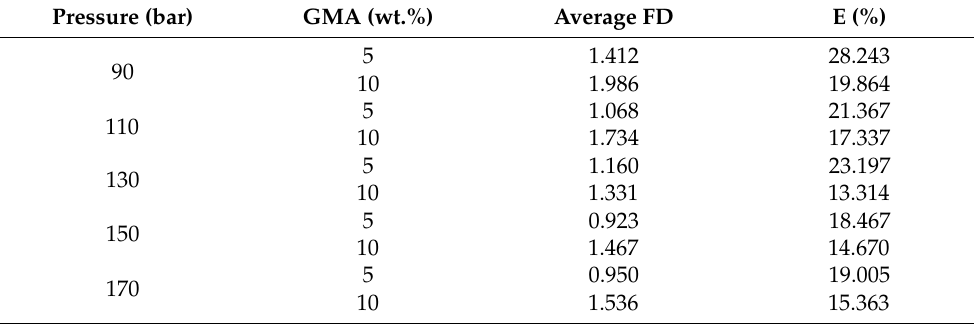
Table A4. Effect of variation in scCO 2 pressure on recycled PE-g-GMA results. Extruder